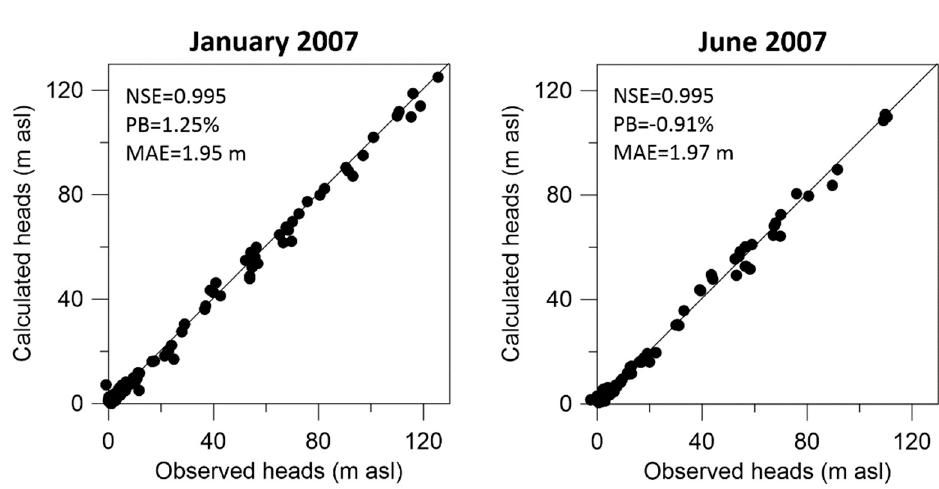
Figure 4. Scatter diagrams of calculated versus observed groundwater heads for the calibrated model in January 2007 ( left graph ) and in June 2007 ( right graph ). The model performance indicators are also reported.